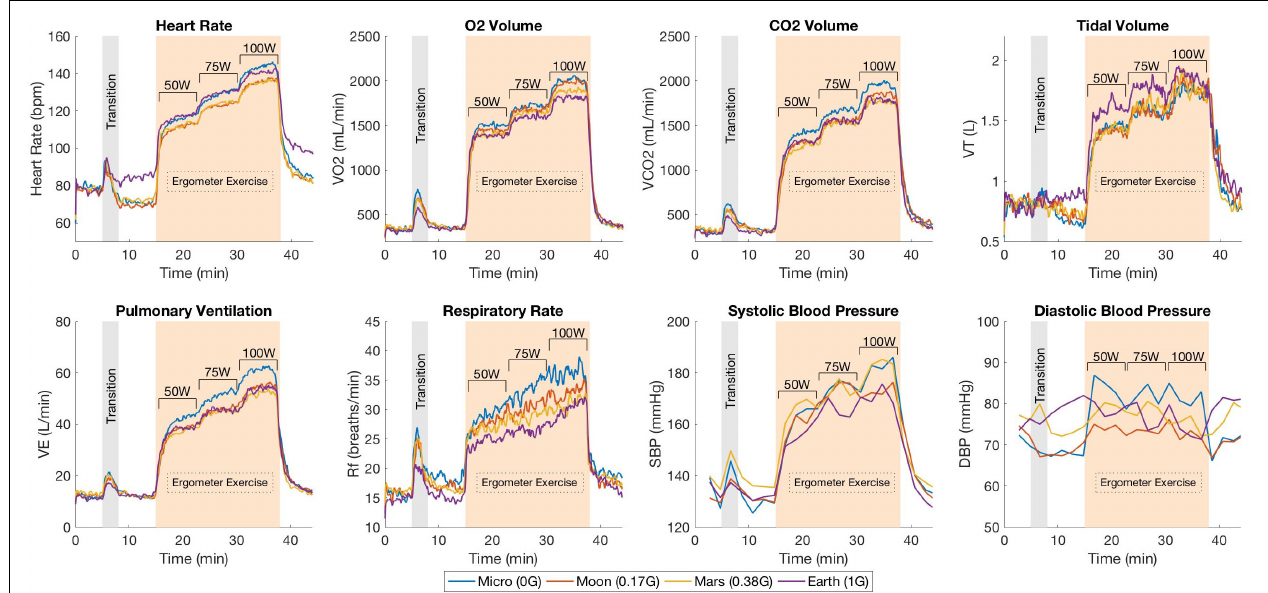
FIGURE 3 | Mean cardiopulmonary responses from 14 subjects during the exercise protocol under the different altered-gravity environments (Microgravity − 6 ◦ HDT, Moon + 9.5 ◦ HUT, Mars + 22.3 ◦ HUT, Earth + 90 ◦ upright). The protocol includes a baseline period in the upright seated position (5 min), a transition period for the subject to get positioned in the desired testing configuration (Microgravity, Moon, Mars, or Earth), another period at rest to capture the new baseline in the new gravitational configuration (7 min), the exercise phase with three workload intensities (23 min including work rate transitions), and a final recovery period (7 min). Systolic and diastolic blood pressure measurements were collected every 2 min and not continuously as the rest of the